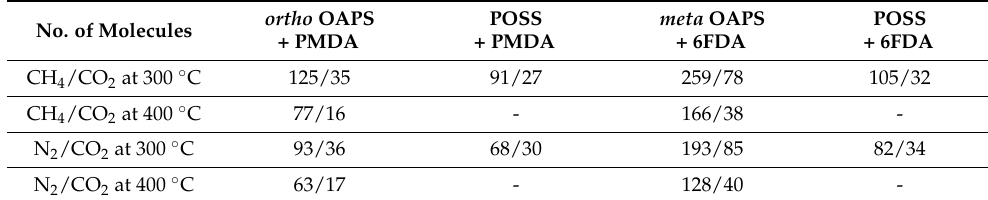
Table 6. Converged numbers of N 2 , CH 4 and CO 2 molecules sorbed by the polyOAPS/POSS-imides networks at 300 ◦ C and 400 ◦ C upon contact with binary 90%/10% mixtures of either CH 4 /CO 2 or N 2 /CO 2 at 60 bar.